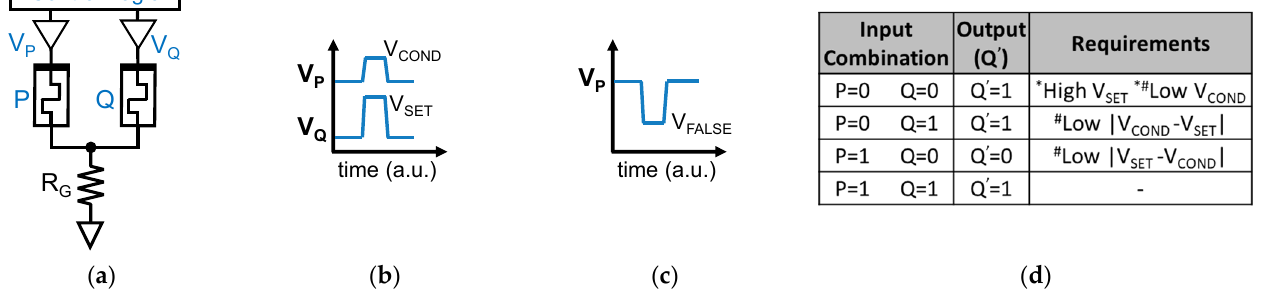
Figure 3. ( a ) Schematic of the IMPLY gate. ( b ) Pulses applied to the top electrodes of P (V P = V COND ) and Q (V Q = V SET ) to execute the IMPLY operation. ( c ) Pulse applied at the top electrode of P (V P = V FALSE ) to perform the FALSE P operation. ( d ) Truth table of the IMPLY operation where the conflicting V SET and V COND requirements for gate functionality (*) and reduced degradation (#) for the four input combinations are evidenced.